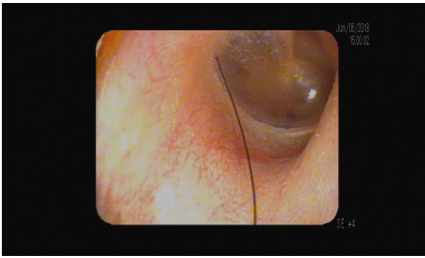
Figure 1: Hair resting on the tympanic